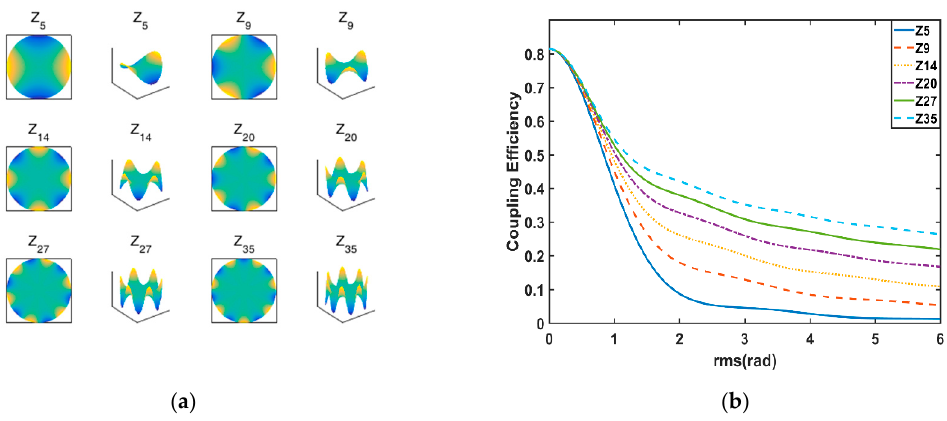
Figure 5. ( a ) Astigmatic aberration patterns; ( b ) CE with an astigmatic item.